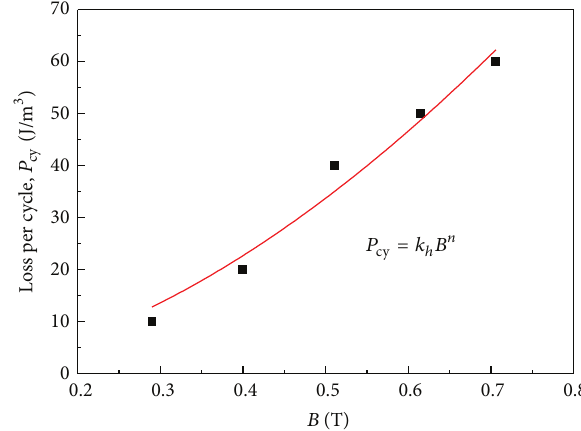
Figure 9: Variation of loss per cycle with 𝐵 at DC magnetic field. Equation (7) is then fitted with 𝑃 constant 𝐵 . The obtained 𝑘 𝑒 and 𝑘